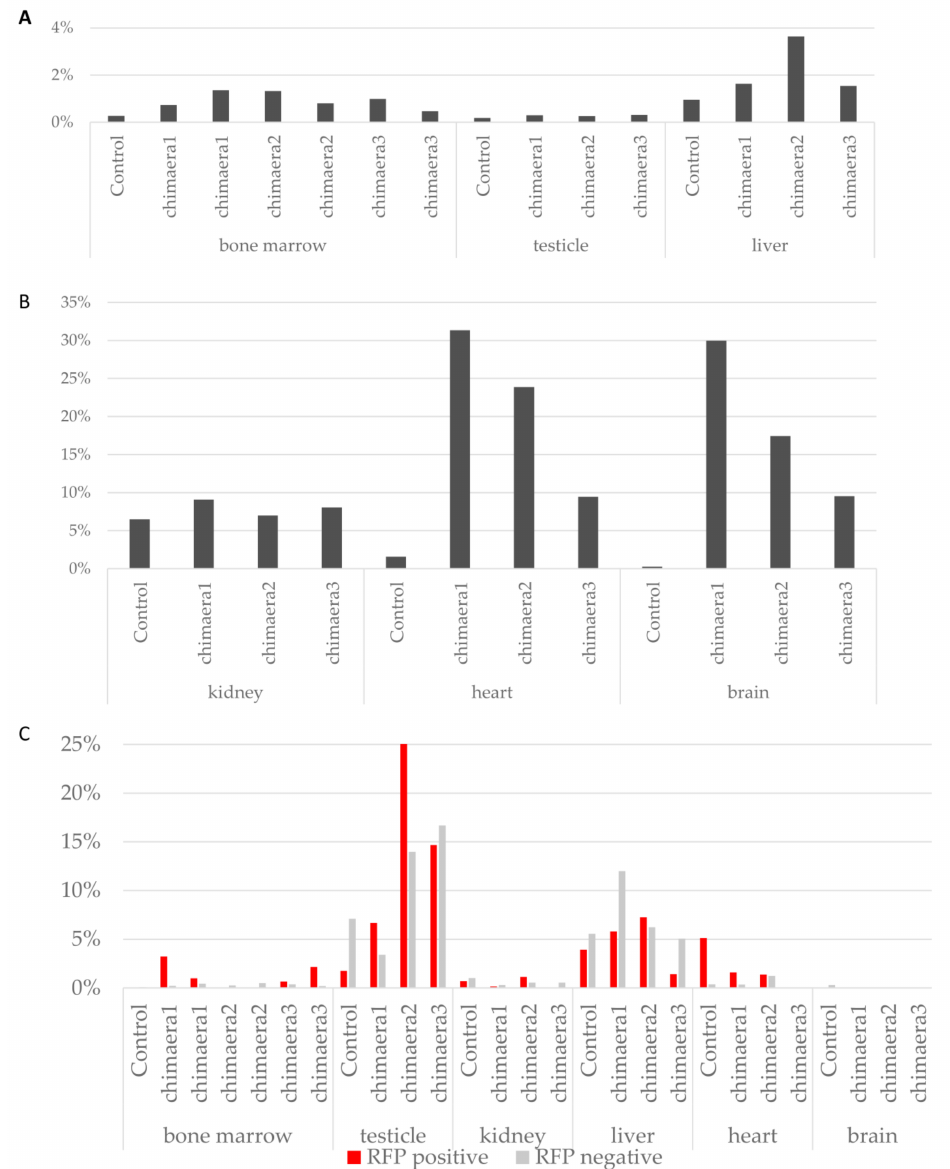
Figure 9. Analysis of donor marker expression in samples from adult animal organs. ( A ), ( B ) Percentage of RFP-expressing cells in organs. Statistically significantly more RFP-positive cells in samples compared to control were found in a chi-square test, p < 0.01: bone marrow (all chimaeric samples), testicle (3), kidney (1), kidney (3), liver (all chimaeric samples), heart (all chimaeric samples), brain (all chimaeric samples). ( C ) Tetraploid cells in G2/M cell cycle phase in RFP-positive and RFP-negative samples. Chart shows percentage of tetraploid cells in groups marked as RFP positive (progeny of donor cells) and RFP